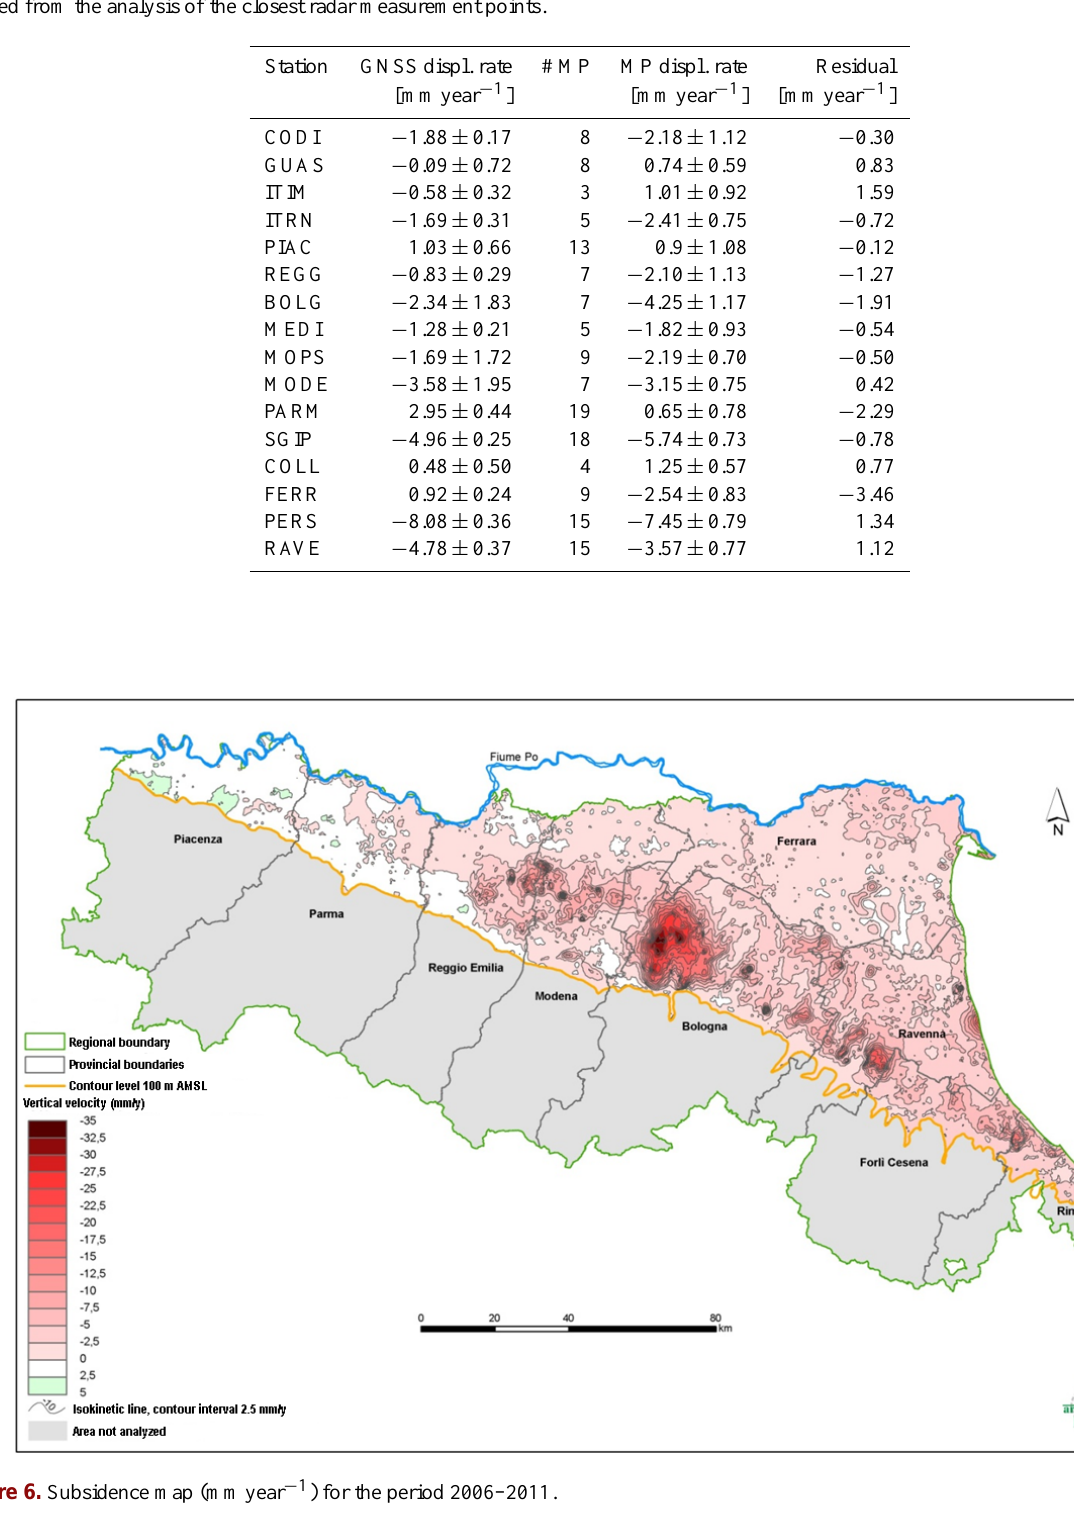
Table 1. Comparison of the residual in the velocities (mmyear − 1 ) between the values obtained from the GNSS permanent stations and those derived from the analysis of the closest radar measurement points.